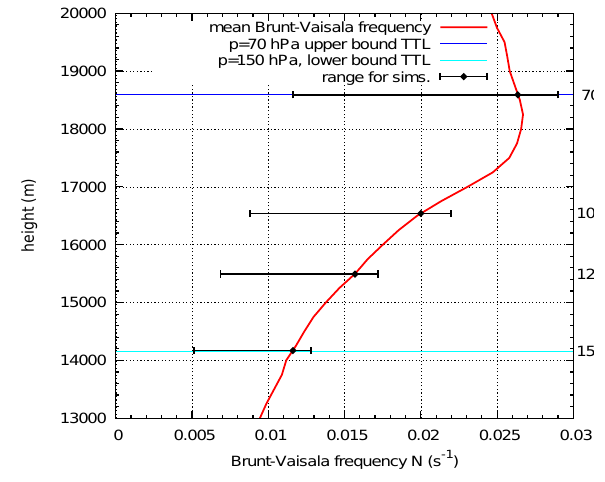
Fig. 7. Vertical profile of static stability (mean Brunt–Väisälä fre- quency) as derived from measurements (Thompson et al., 2003). Additionally, the range for the initialization of the simulations is in- dicated by horizontal black bars, where we set N mean ≈ 0 . 9 · N max (red line and black dots); thus, the bars show the interval 0 . 4 · N max ≤ N ≤ N max as described in detail in Sect. 5.1; the values of N max , N mean and N min = 0 . 4 · N max , respectively, are reported in Table 1.